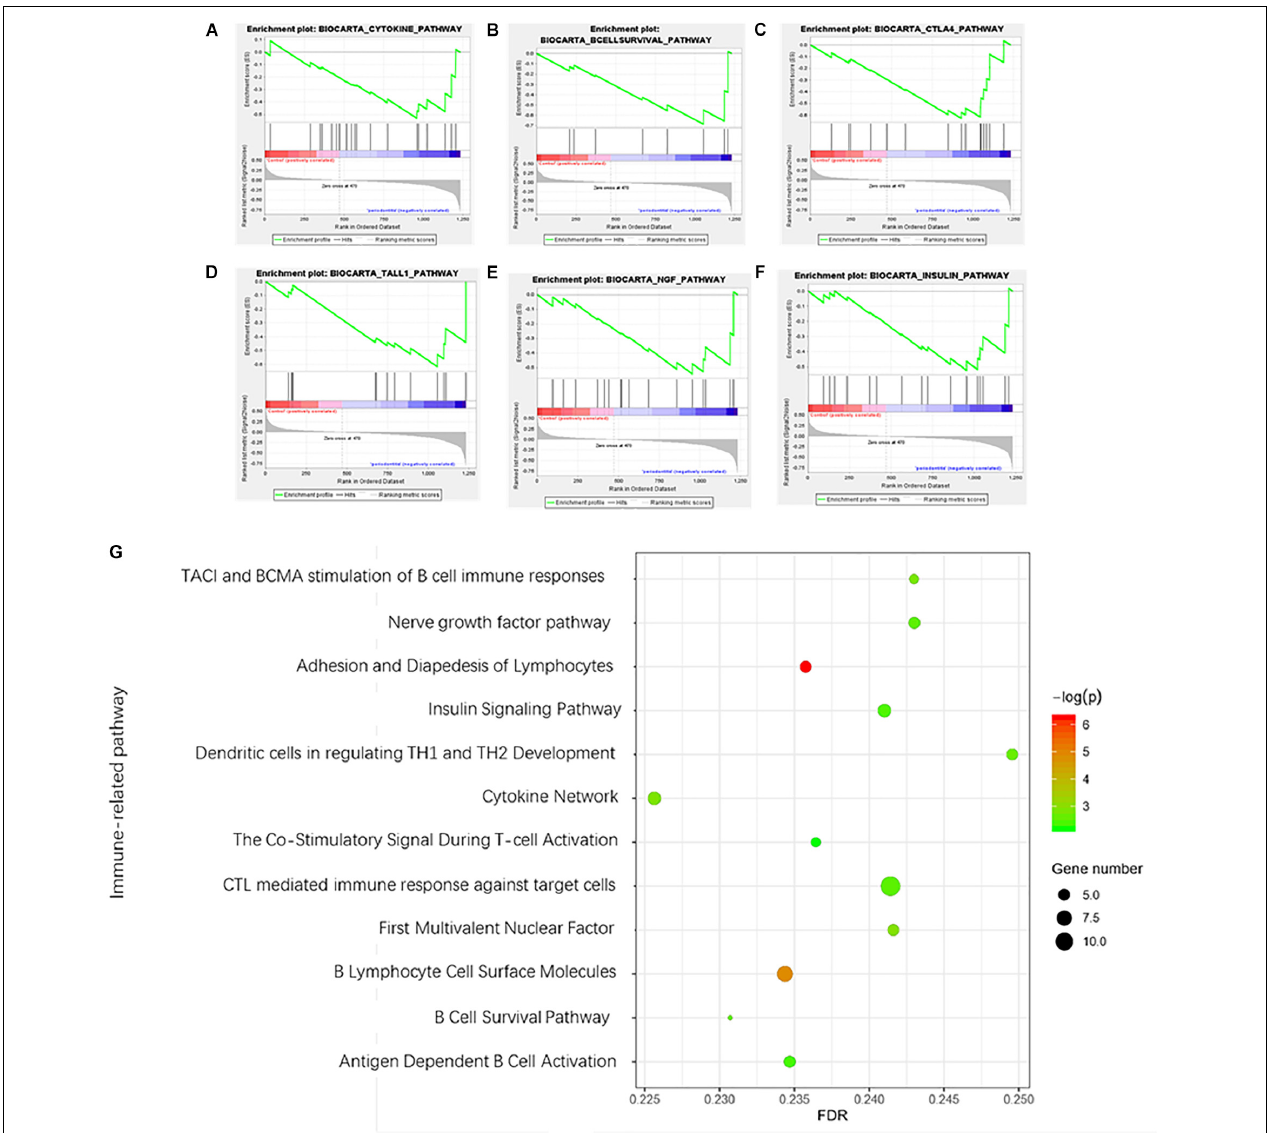
FIGURE 4 | Gene set enrichment analysis of immune-related pathways in periodontitis. (A) Cytokine network pathway; (B) B cell survival pathway; (C) Costimulatory signal during T-cell activation; (D) TACI and BCMA stimulation of the B cell immune response pathway; (E) Nerve growth factor pathway; (F) Insulin signaling pathway. (G) Bubble diagram of enriched immune-related pathways.